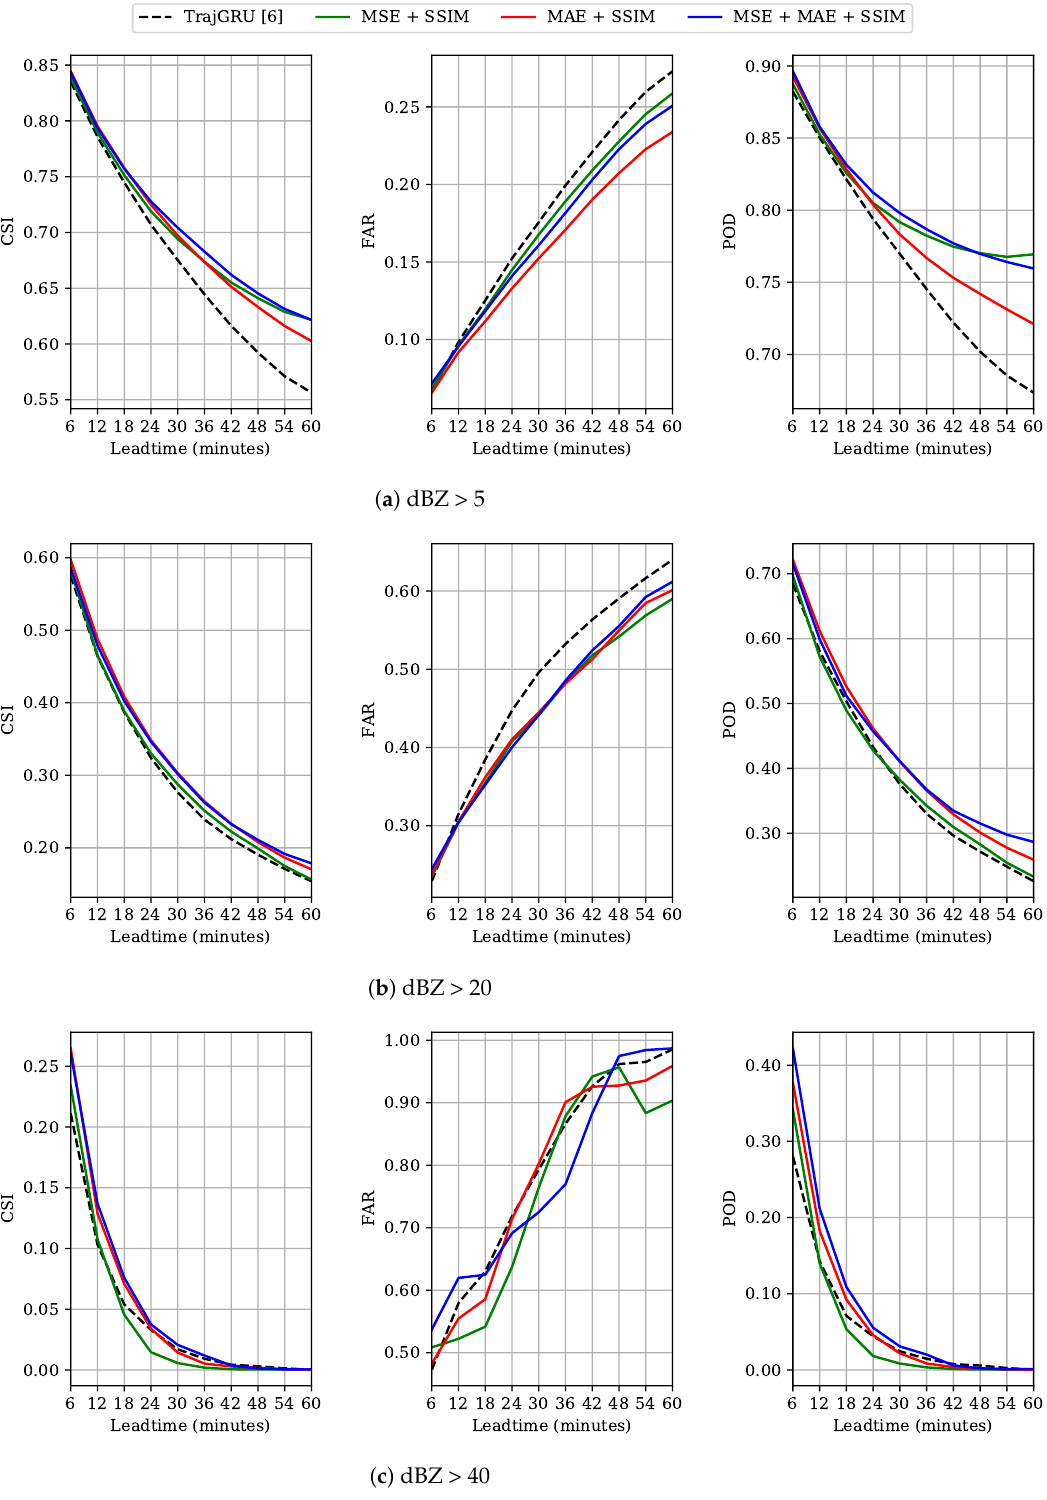
Figure 9. Frame-wise CSI, FAR and POD scores of of predicting rainfall situations at different dBZ thresholds. Best view in color.